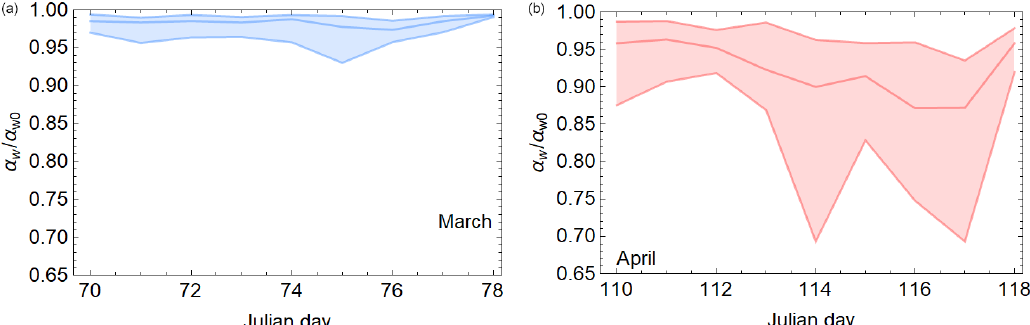
Figure 11. Ratio of simulated total and bulk white-sky albedo values for all 1381 profiles and snow pit and impurity data in Sodankylä in 11–19 March and 20–28 April 2009. The daily mean, minimum and maximum values are indicated by the darker curve, and the variation range is shaded.